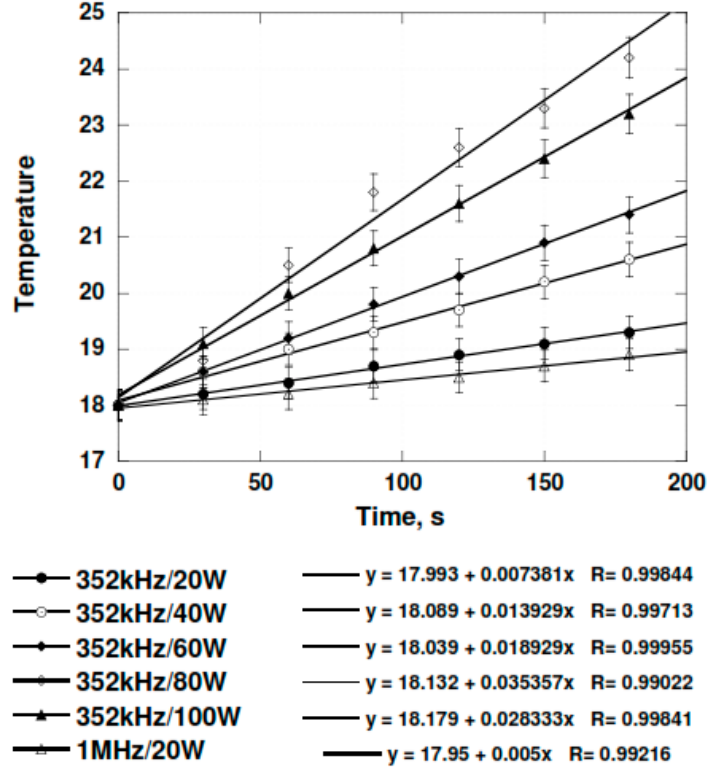
Figure 2. Evolution of the temperature in the sonochemical reactor containing water (400 mL).